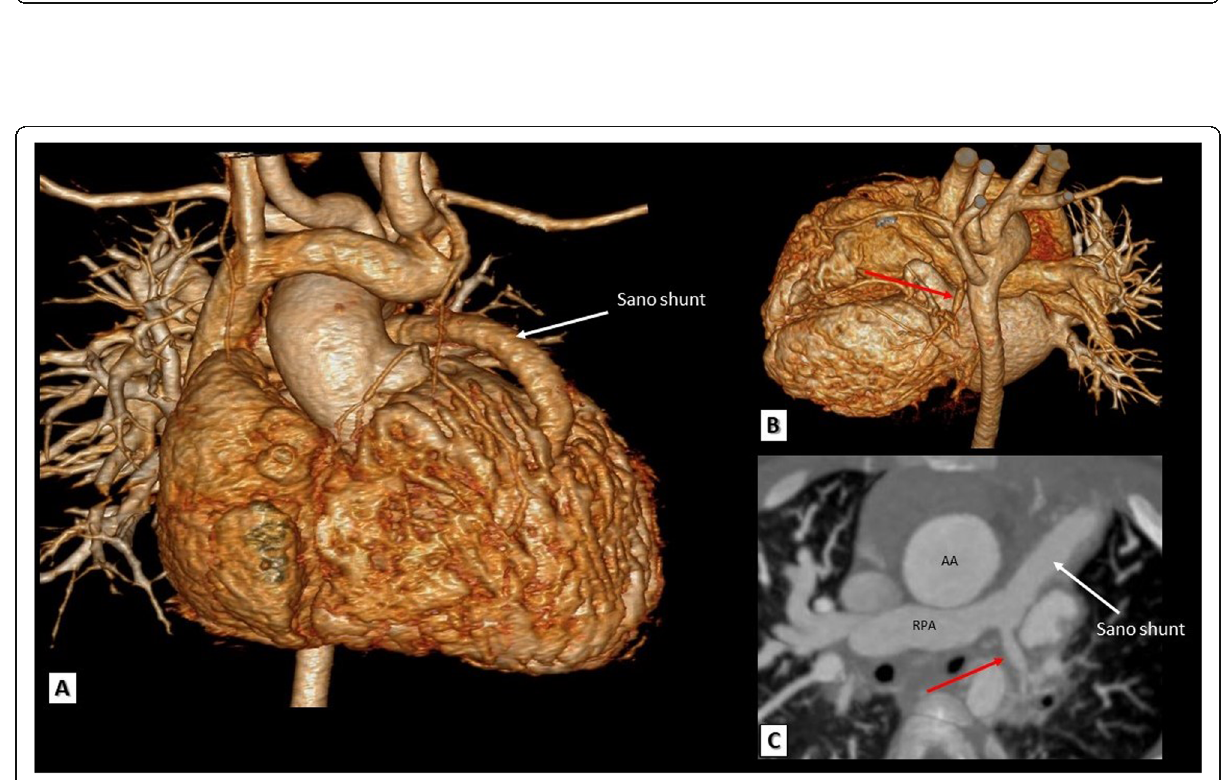
Fig. 10 a, b A TOF patient with right MBT shunt. a 3D VRT and b reconstructed coronal MDCT images showing a patent MBT shunt between the right subclavian artery and right pulmonary artery. c , d Another TOF patient with also right MBT shunt. c 3D VRT and d reconstructed coronal MDCT images showing a significant stenosis at the pulmonary end of the MBT shunt. RPA, right pulmonary artery; LA, left atrium; LV, left ventricle